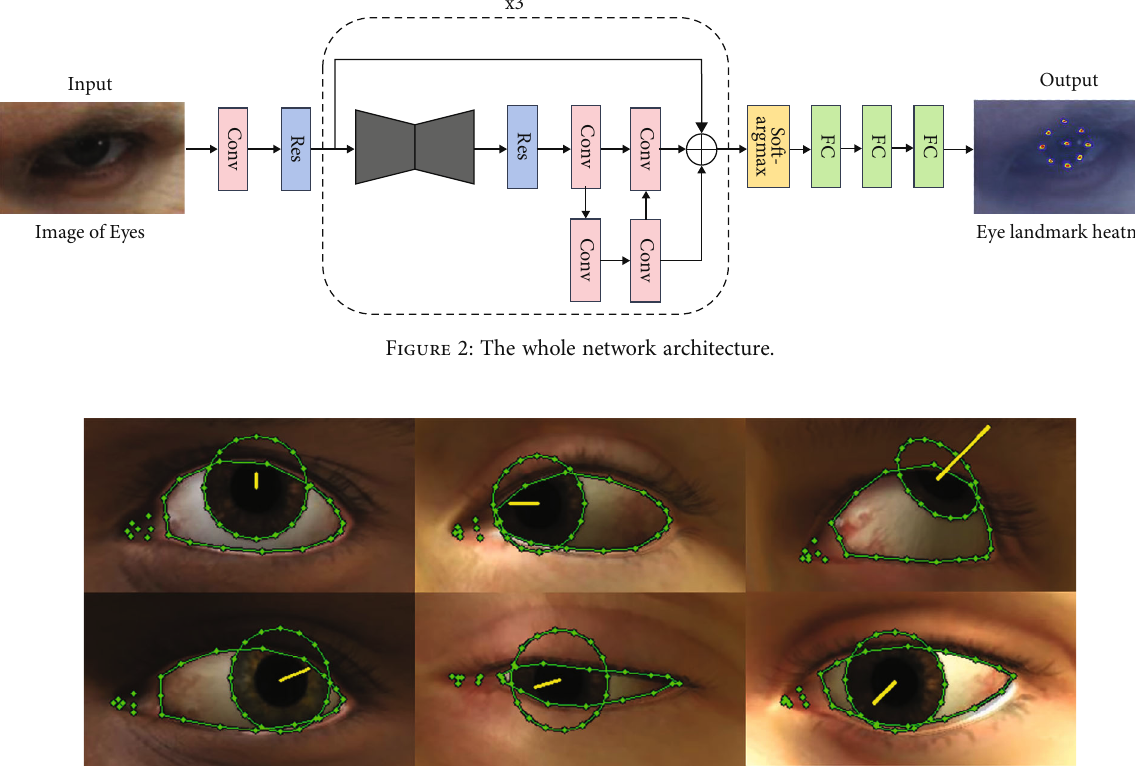
Figure 1: The four-level hourglass module.